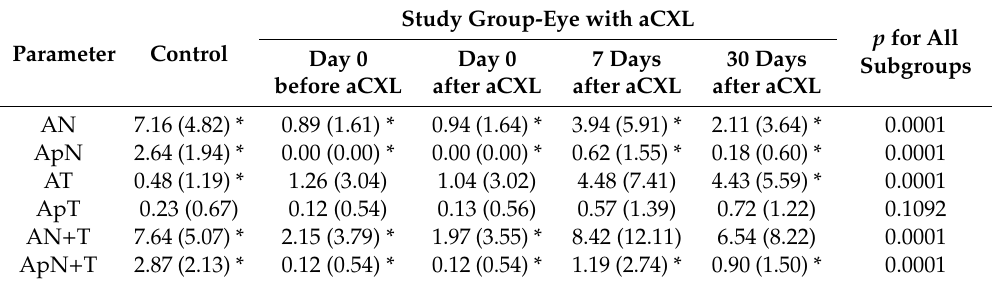
Table 1. Comparison of autofluorescence parameters between control group and eyes treated for keratoconus. Parameters presented in mm 2 as a mean and